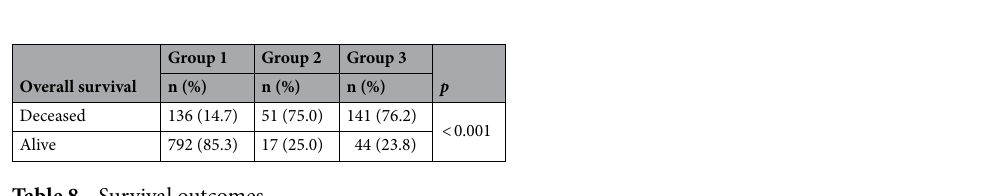
Table 8. Survival